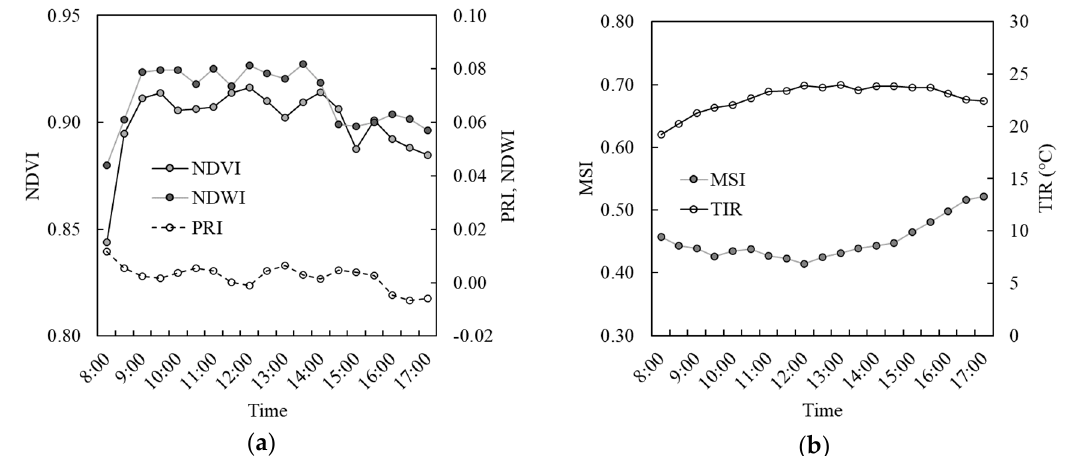
Figure 3. Diurnal trajectories of ( a ) NDVI, NDWI, and PRI calculated from the hyperspectral reflectance measurements and ( b ) the MSI and plant canopy temperature measured by the thermal infrared (TIR) sensor on 21 August 2015 (DoY 234).